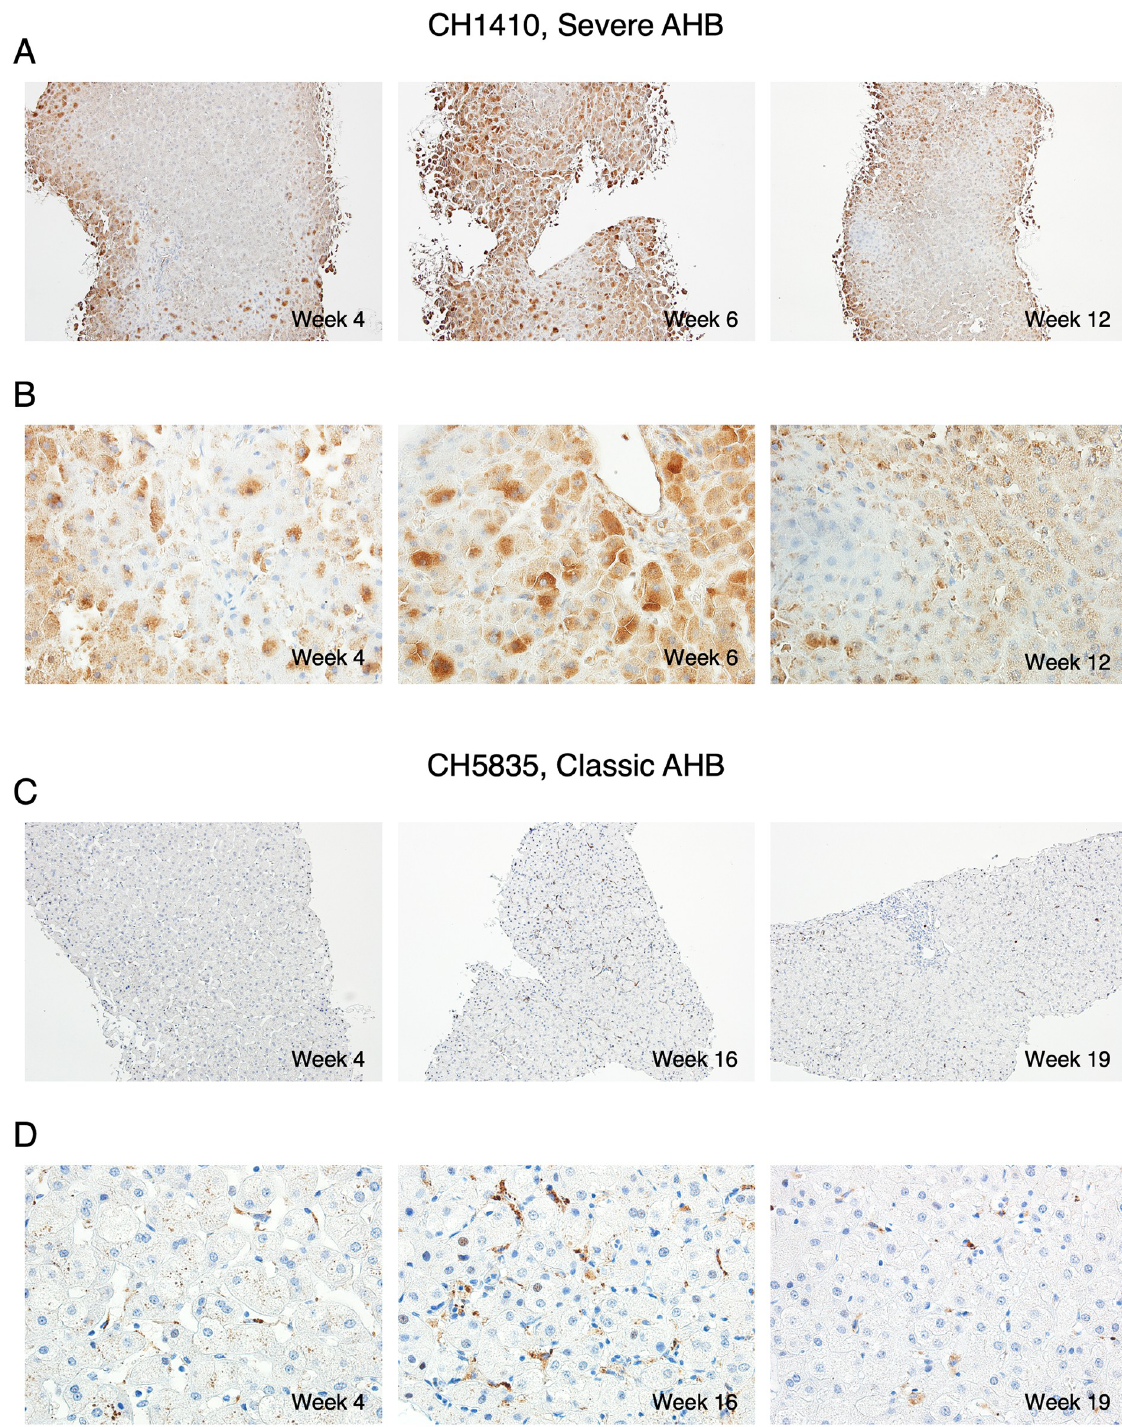
Fig 4. Immunohistochemical staining for caspase 3 activation in serial liver biopsies during acute HBV infection in chimpanzees. (A and B) Paraffin sections from CH1410, infected with a precore HBV mutant [15], and CH5835 (C and D), infected with the wild-type HBV strain [11, 14]. Immunostaining showed the highest caspase 3 activation in CH1410 (A and B) at the time of the ALT peak (week 6, ALT 1202). Panel A, 10X magnification images and panel B, 40X magnification images. (C and D) Immunostaining in CH5835 did not show detectable caspase 3 activation throughout the course of the disease. Panel C, 10X magnification images and panel D, 40X magnification images. AHB denotes acute hepatitis B.